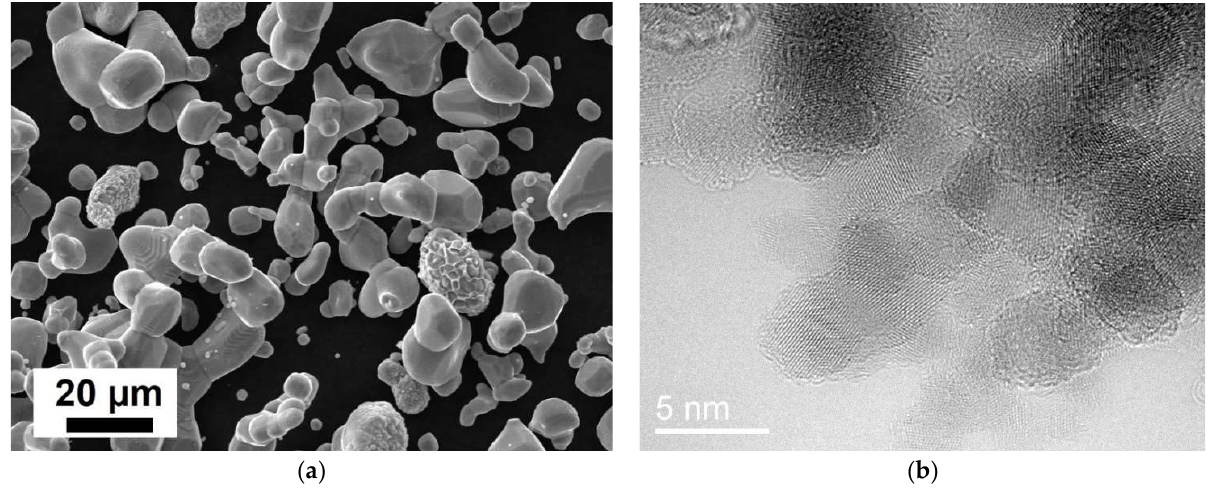
Figure 1. Initial materials: ( a ) chromium particles (SEM); ( b ) nanodiamonds